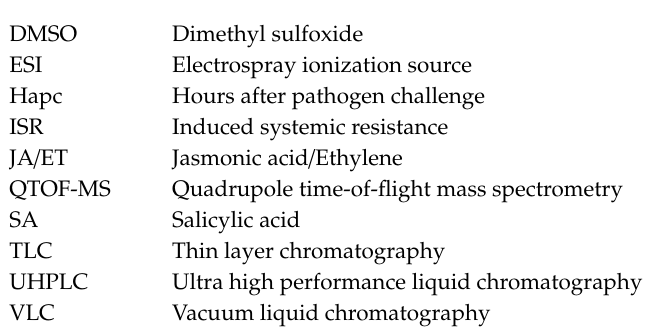
Figure S1. Experimental MS / MS spectra for the aryl alkylamines detected in the extract at the collision energy (30 eV) in positive; Figure S2. Experimental MS / MS spectra at the collision energy (30 eV) in positive and